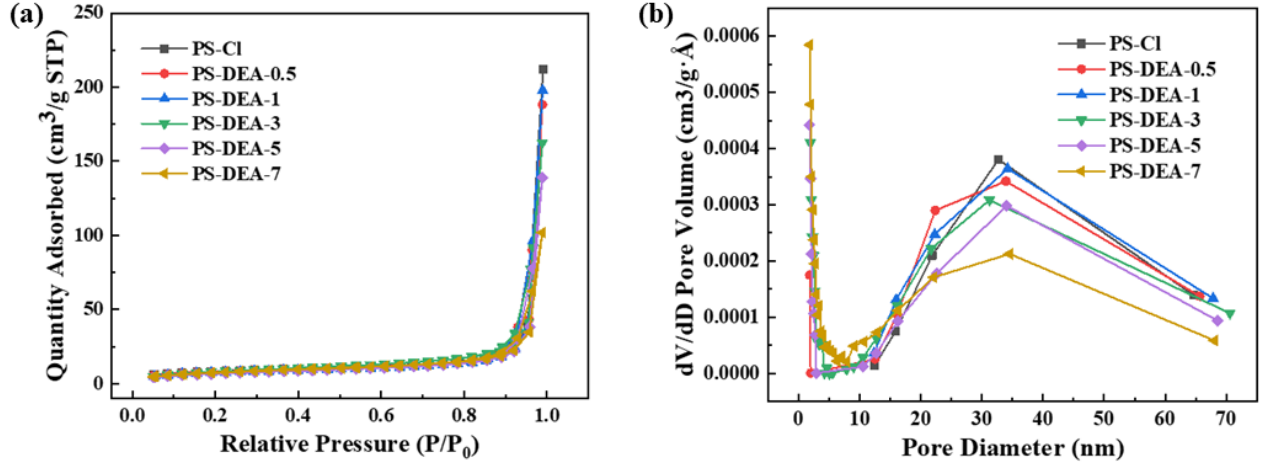
Figure 2. TG analytical curves of PS − DEA − x.